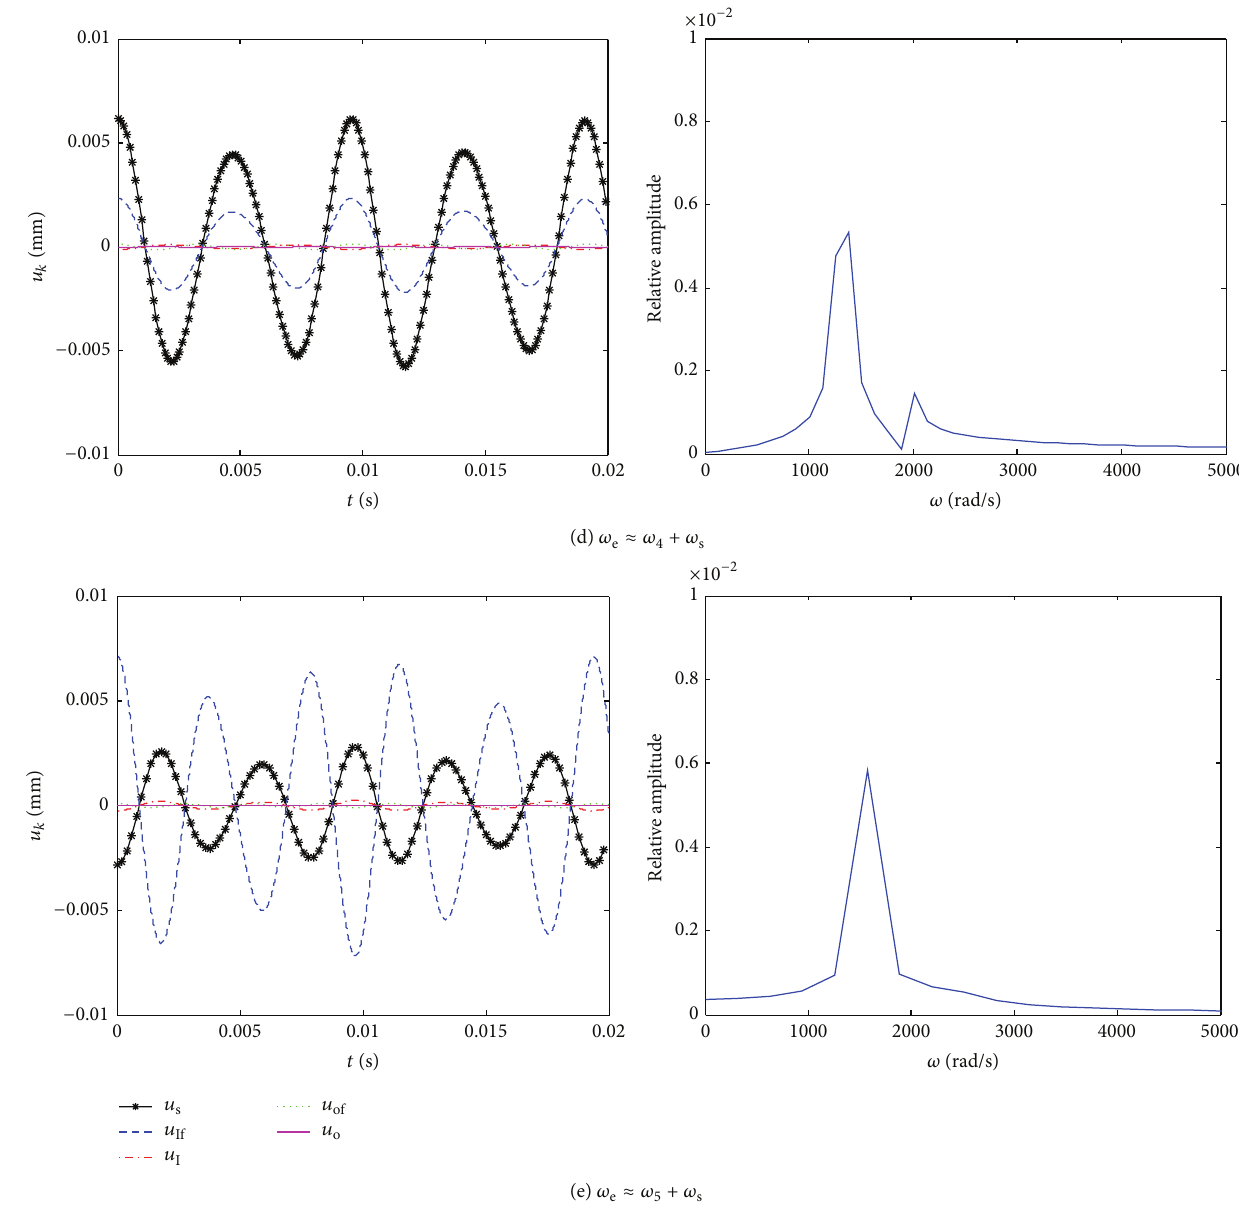
Figure 7: Combination resonance of the EIMG system with 𝜔 e ≈ 𝜔 𝑘 + 𝜔 s .